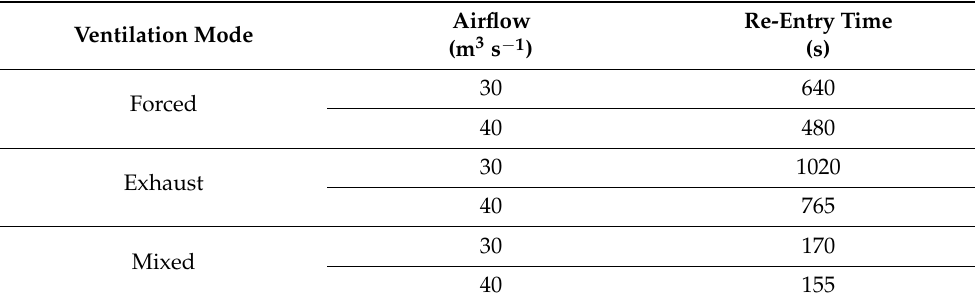
Table 4. Summary of the re-entry time